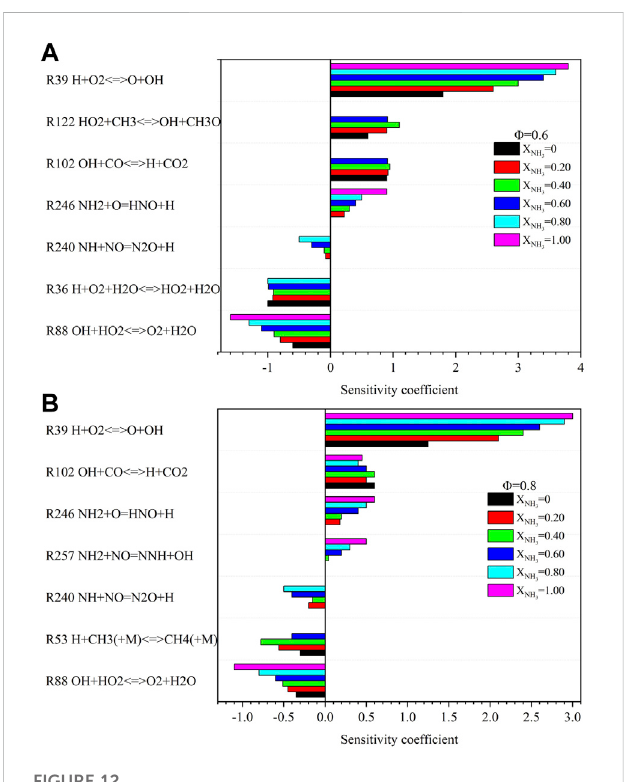
FIGURE 12 Sensitivity analysis of NO with different ammonia content: (A) Φ = .6; (B) Φ = .8. (T = 723 K, p = 16.5 atm).